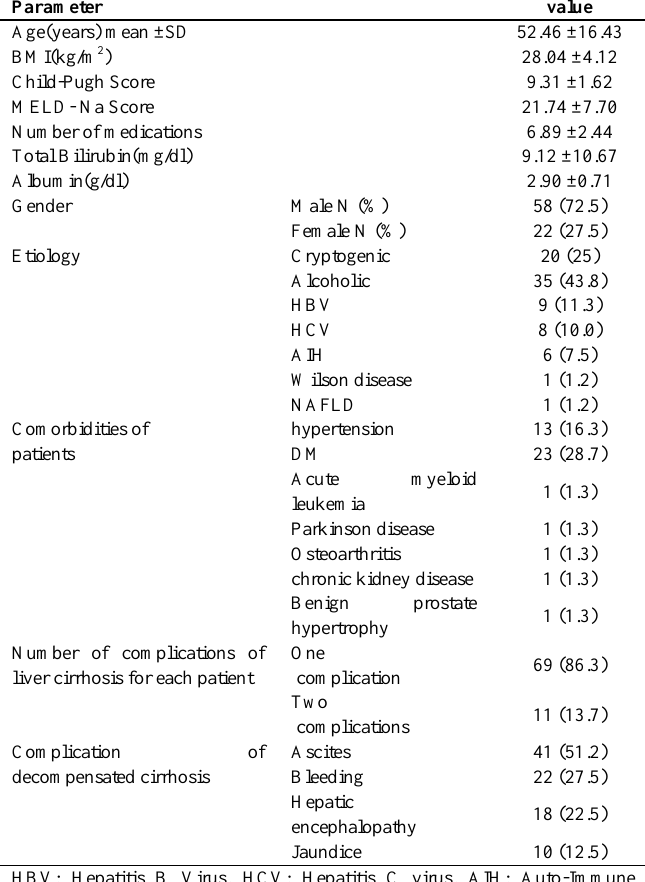
Table 1: Demographic data and clinical characteristics of the study sample